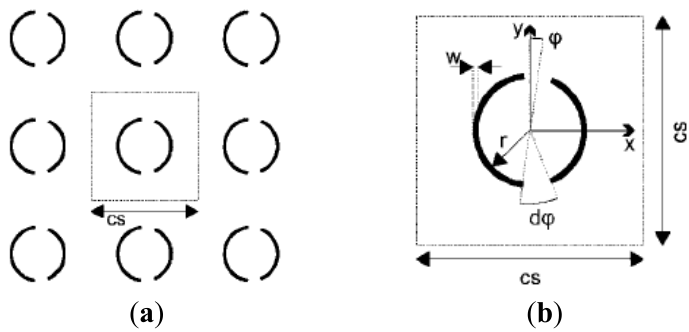
Figure 3. ( a ) Schematic section of aDSR based FSS adopting a square lattice and ( b )